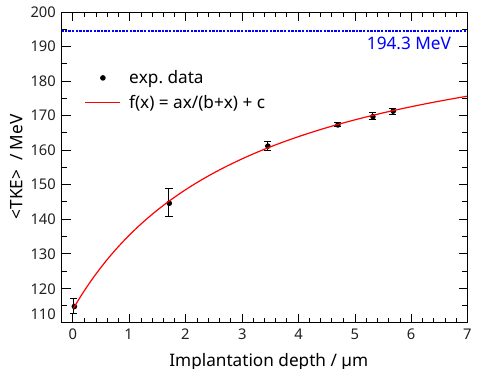
Figure 2. TKE from the SF of 252 No vs. implantation depth of ER in the detector. Blue dashed line: TKE = 194 . 3MeV of 252 No from [3]. Red solid line: saturation-growth fit.